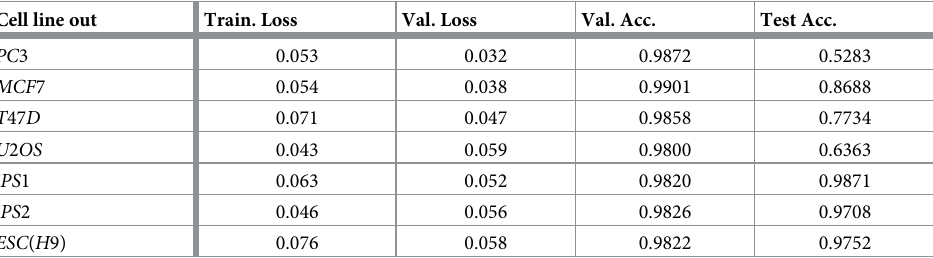
Table 2. Model performance after removing a cell line from training.